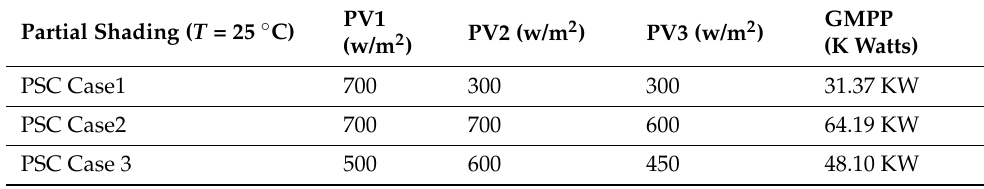
Table 3. Partial shading